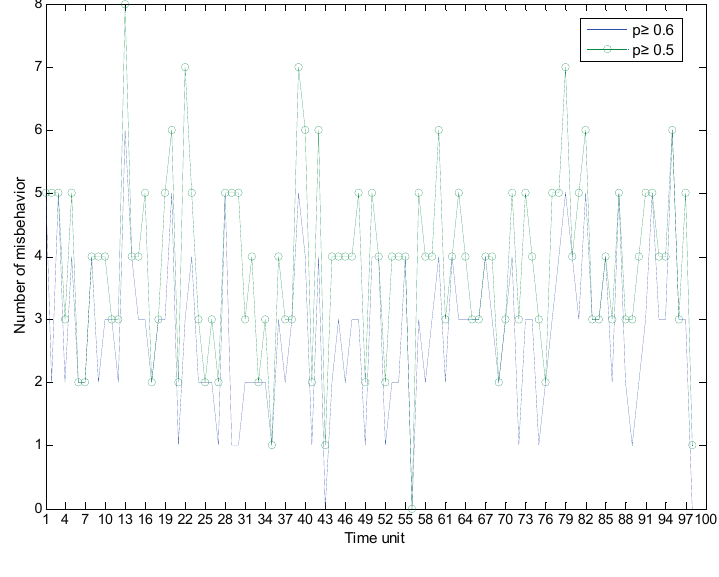
Figure 4. Generated number of misbehaviors.